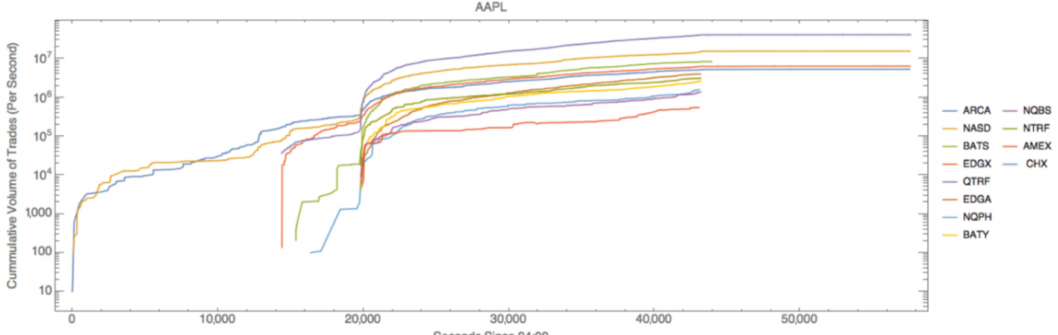
Figure 8. Cumulative trade volume by exchange for Apple stock on 11 August 2015 summed each second from 04:00 until